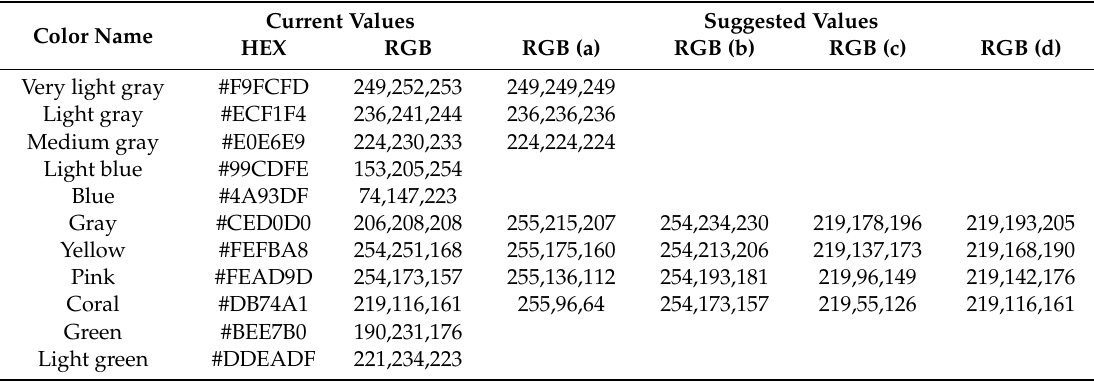
Table A3. HERE Maps colors